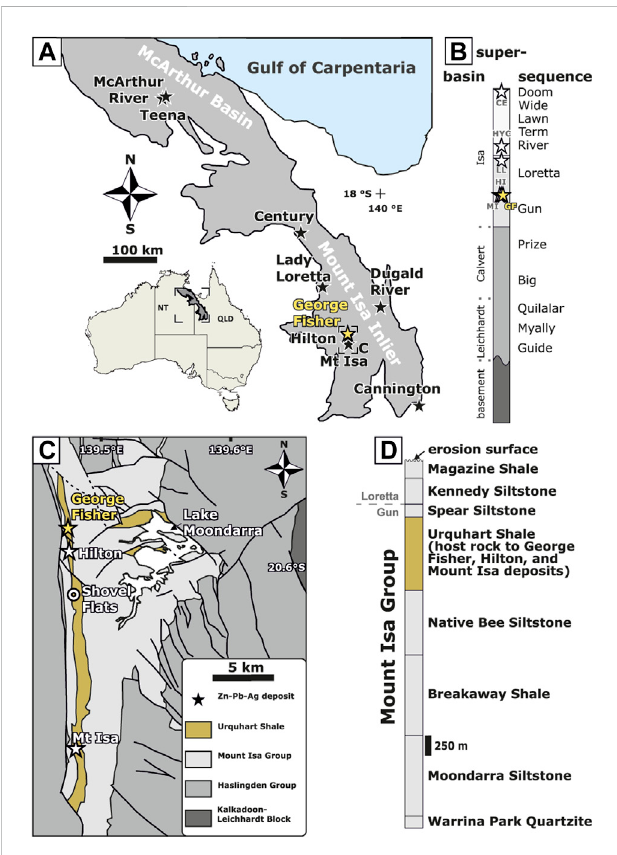
FIGURE 1 (A) A map of the Carpentaria Province. Stars denote major Zn-Pb deposits. (B) Simpli fi ed superbasin stratigraphy for the Mount Isa Inlier (after Southgate et al., 2000). The approximate locations of the George Fisher (GF), Hilton (HI), Mount Isa (MI), Lady Loretta (LL), McArthur River (HYC), and Century (CE) clastic-dominated Zn-Pb massive sul fi de depositsaredenotedbystars. (C) Asimpli fi edmapofthelocalgeologyin the Mount Isa area (after Gibson et al., 2017). (D) The stratigraphy of the Mount Isa Group (formation thicknesses are adapted from Neudert,